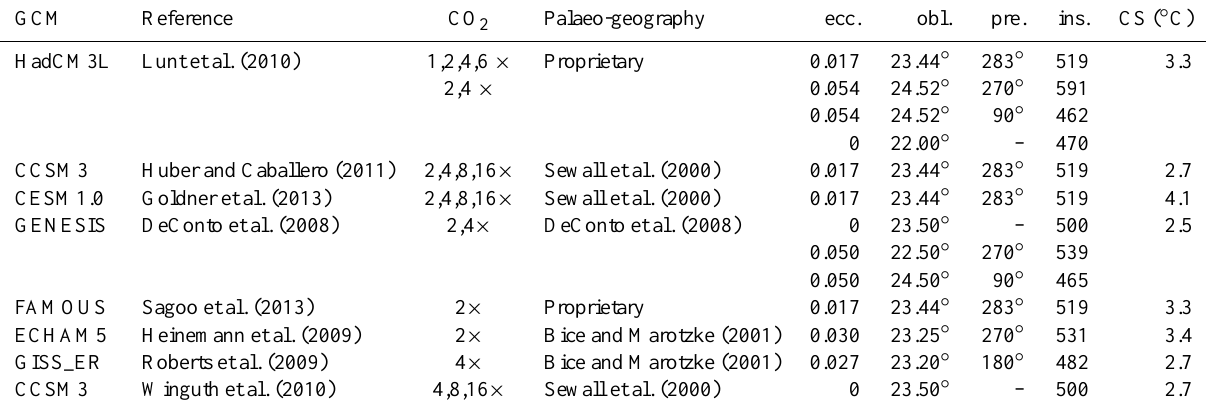
Table 1. Summary of GCM simulations, see Lunt et al. (2012) for a full description of the simulations. Astronomical parameters: eccentricity (ecc.), obliquity (obl.) and longitude of precession (pre.), with insolation (ins.) for January at 70 ◦ S also shown (Wm − 2 ). CS is the modern- day equilibrium climate sensitivity for the GCMs, excluding vegetation and chemical